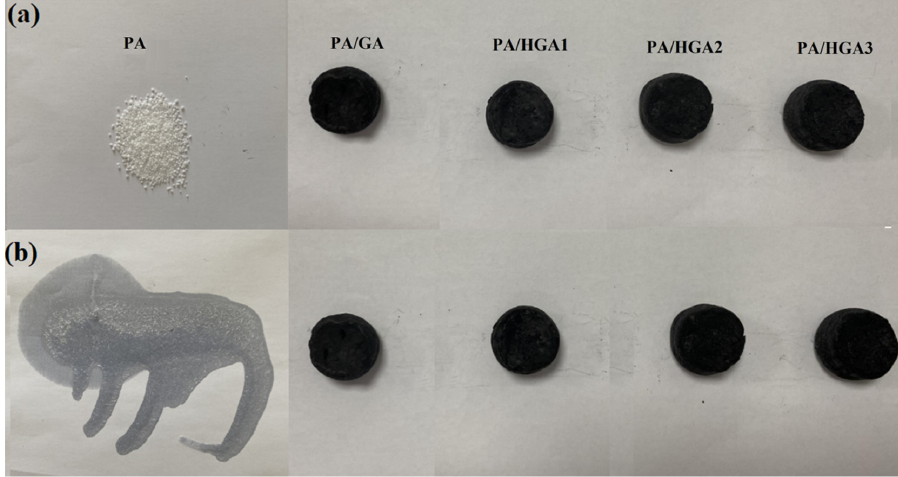
Figure 10. Photos of PA and PA/HGA heated at 80 °C for 0 min ( a ) and 30 min ( b ). Figure 11a exhibits the DSC curves of PA/HGA3 before and after 100 thermal cycles.